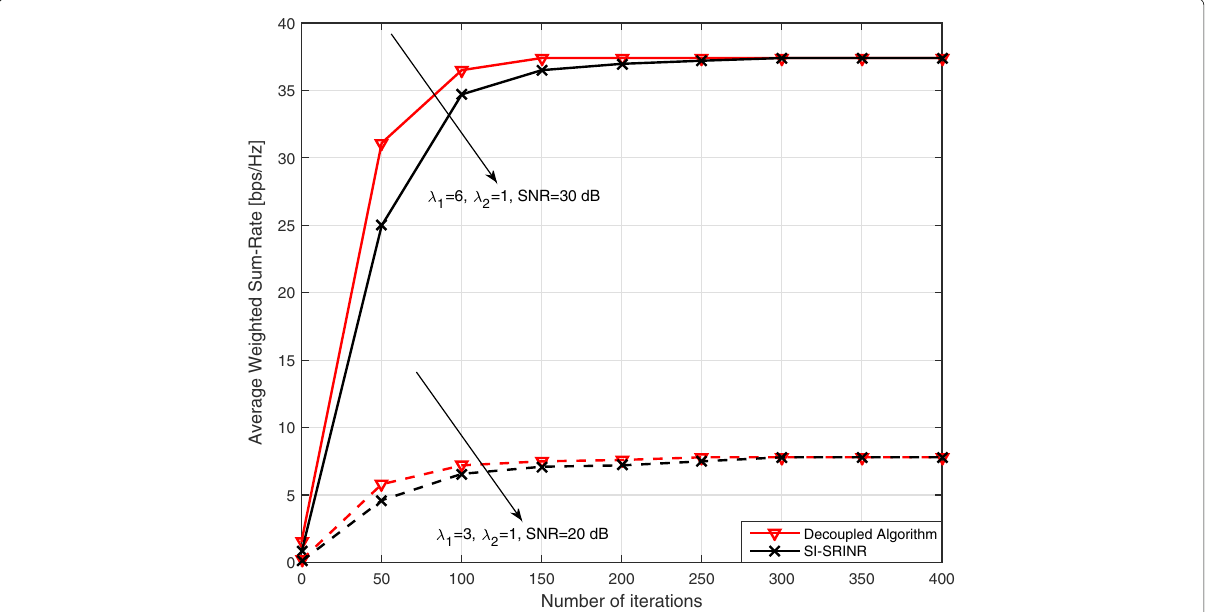
Fig. 3 The average weighted SR versus the number of